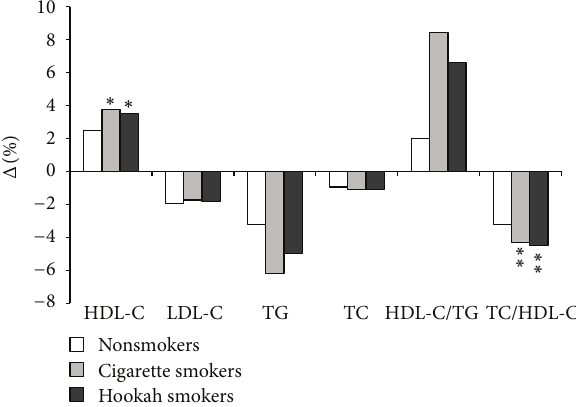
Figure 3: Lipid improvement rate in percentage of the three groups after training program. HDL-C: high-density lipoprotein choles- terol; LDL-C: low-density lipoprotein cholesterol; TC: total choles- terol; TG: triglycerides; ∗ 𝑃 < 0.05 ; ∗∗ 𝑃 < 0.01